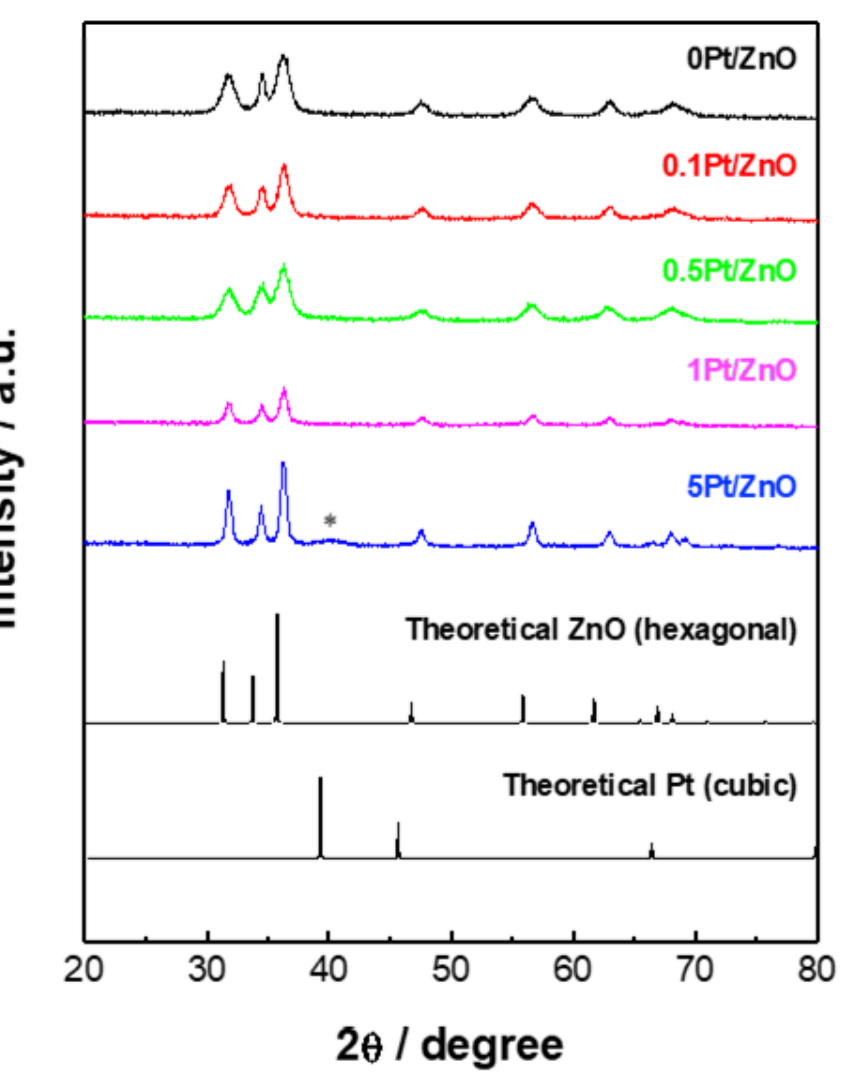
Figure 2. XRD patterns of ZnO NCs with different Pt-loading amounts. * Peak ascribed to Pt 0 .